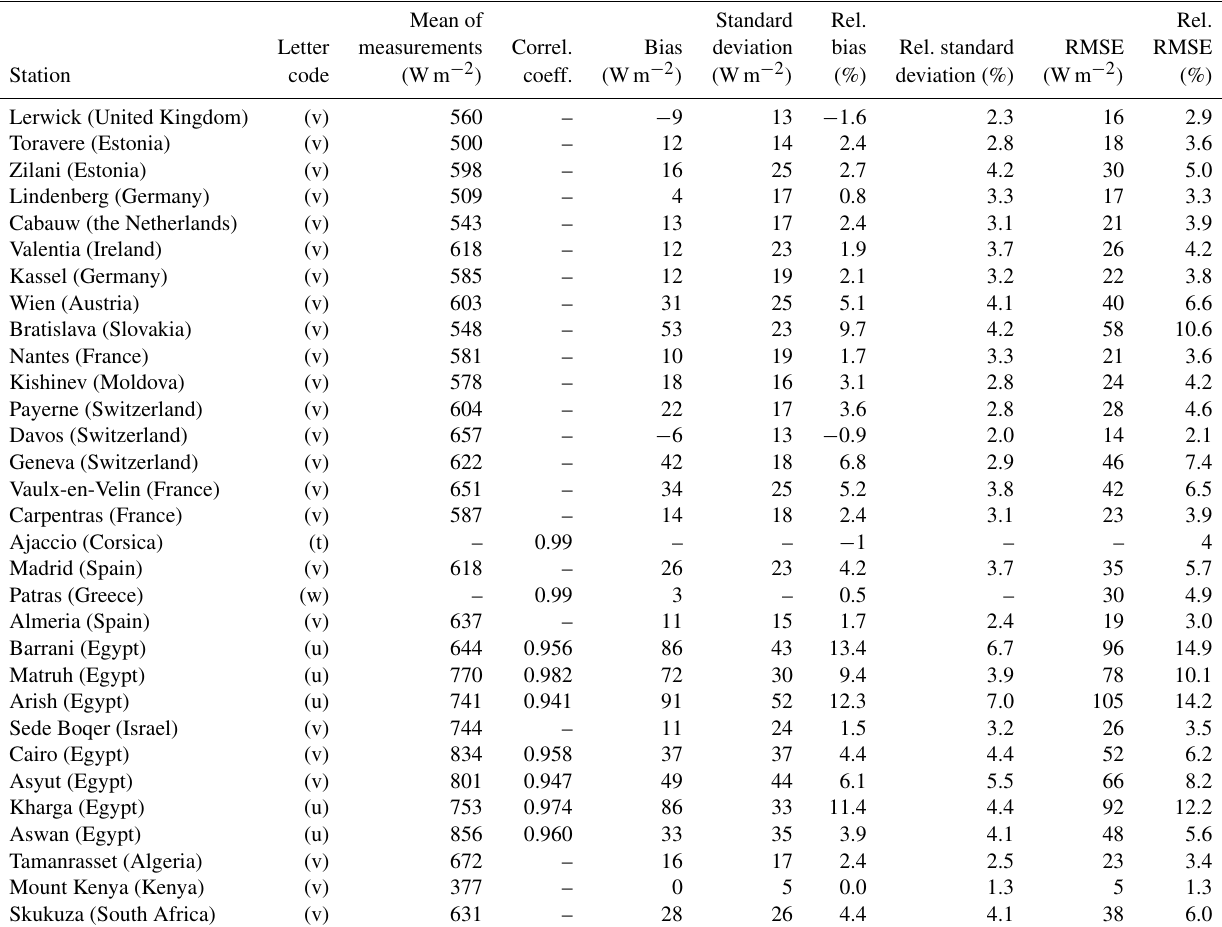
Table B3. Results from previous works at summarization 1h. Means of the measurements, correlation coefficients, bias, standard deviations, RMSE, and their values relative to the mean of the measurements for G .